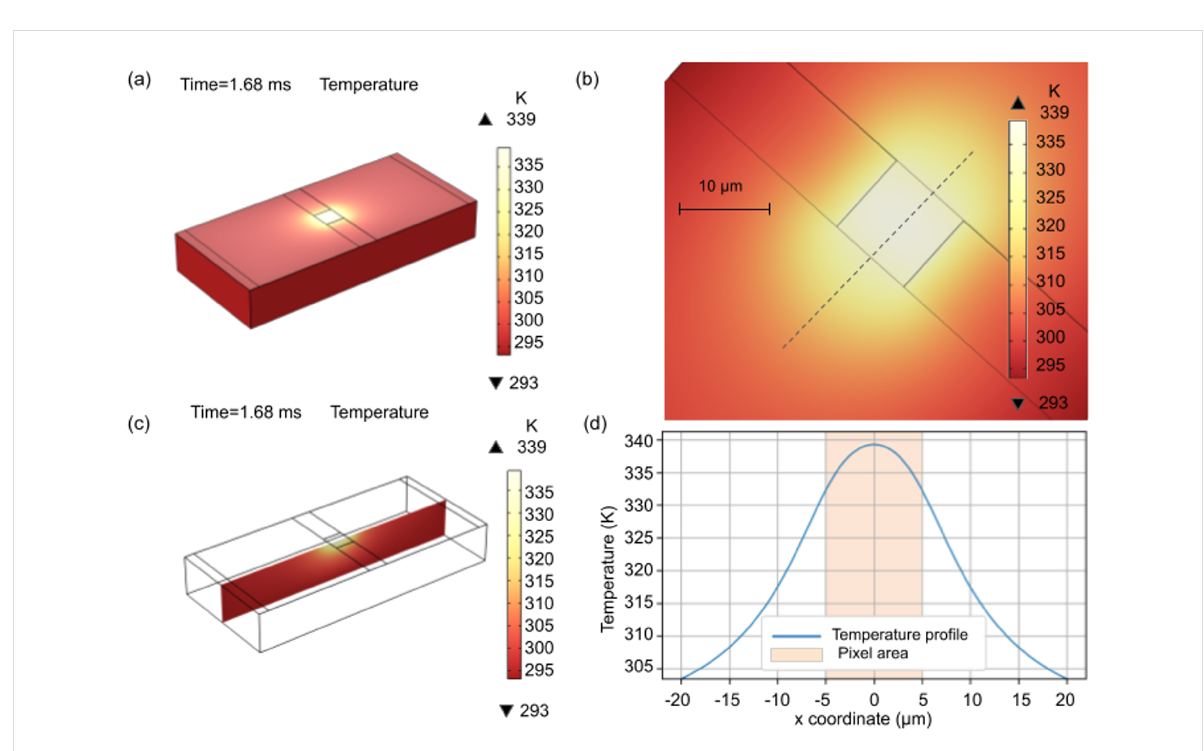
Figure 12: Results of thermoelectrical simulations done with COMSOL. (a) Surface temperature distribution for the whole structure and (b) in the neighbourhood of the constriction. (c) Temperature distribution on the xz -surface at y = 0 and (d) temperature distribution profile along the x -direction.